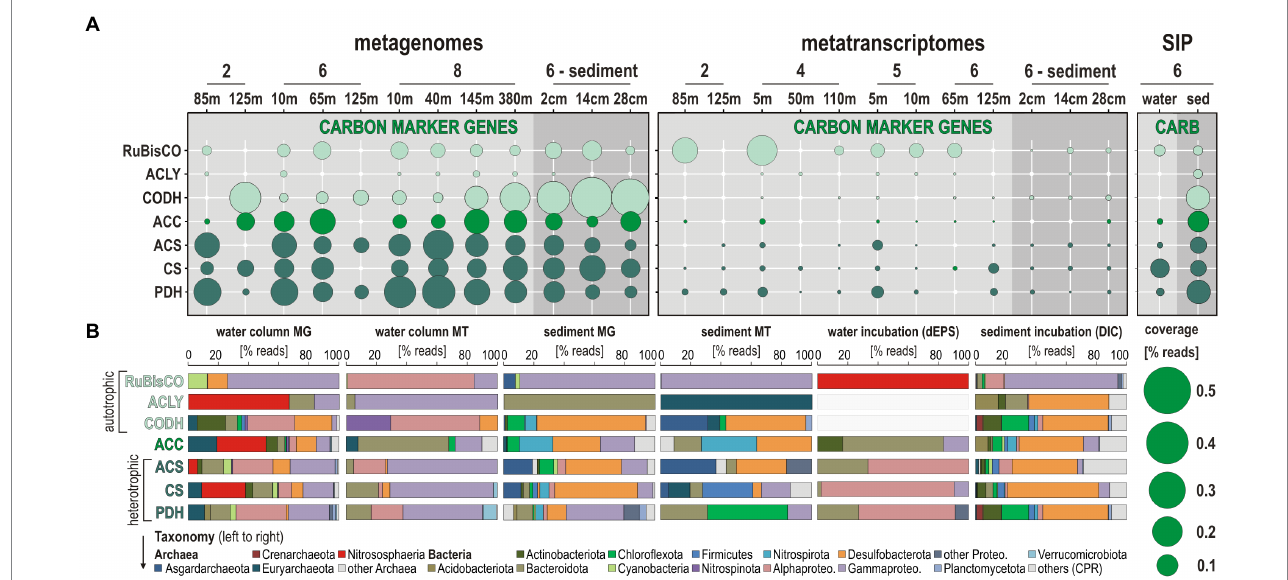
FIGURE 7 Metabolic functions and activities related to autotrophic and heterotrophic carbon assimilation in the water column, sediment, and SIP incubations, and the corresponding taxonomic assignments at the phylum level. (A) Bubble plot showing the relative potential and expression of metabolic functions [% total reads] assigned to marker genes involved in autotrophic-heterotrophic carbon assimilation in the metagenomes, metatranscriptomes, stable-isotope probing (SIP) water, and sediment incubations (left to right). (B) Taxonomic bar charts [% reads] for the corresponding marker genes at the phylum level in the metagenomes (MG), metatranscriptomes, (MT), and SIP incubations with water and 13 C-labeled dEPS and with sediment and 13 C-labeled bicarbonate (DIC). Abbreviations: RuBisCO: ribulose-1,5-diphosphate carboxylase (i.e., CBB cycle)/ACLY: ATP-citrate lyase (i.e., reductive TCA cycle)/CODH: carbon monoxide dehydrogenase (i.e., Wood-Ljungdahl pathway)/ACC: acetyl-coenzyme A carboxylase (i.e., HP/HB-DC/HP cycle)/ACS: acetyl-coenzyme A synthetase (i.e., glycolysis)/CS: citrate synthase (e.g., TCA cycle)/PDH: pyruvate dehydrogenase (i.e., lactate/pyruvate